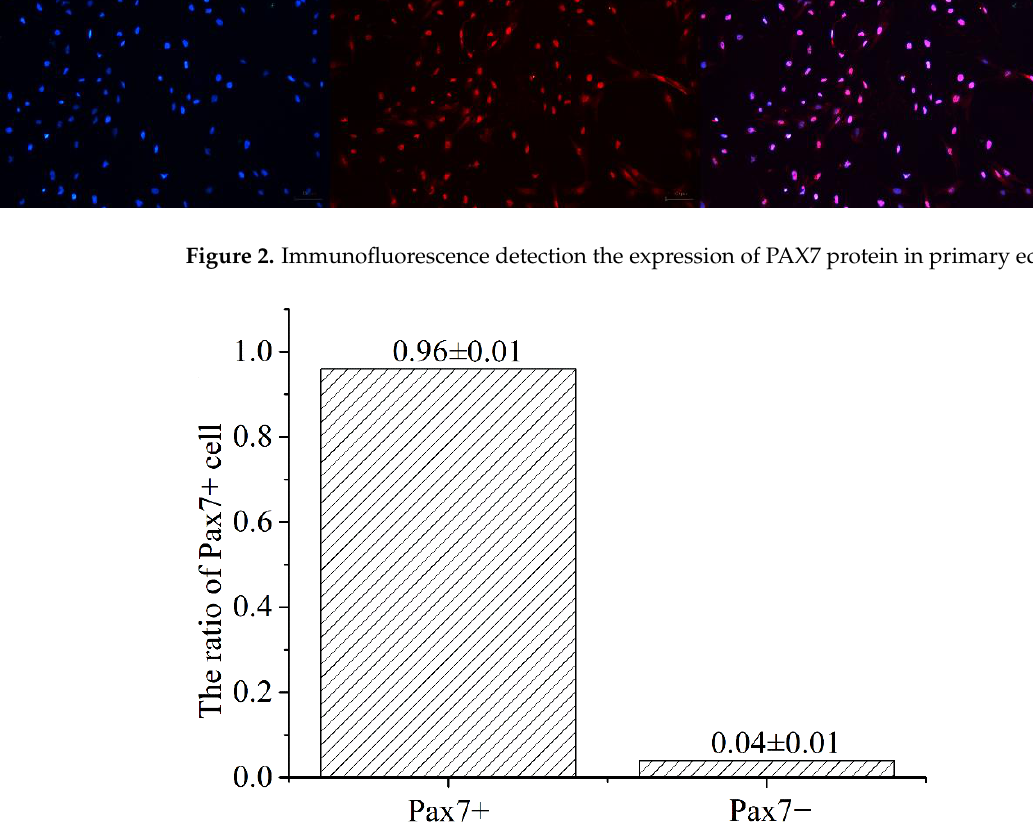
Figure 3. Statistics analysis on the purity ratio of PAX7+ using immunofluorescence staining. Result was presented as mean ± SEM.